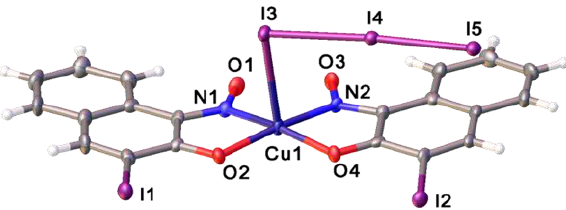
Figure 2. View of the molecular structure of 1 obtained from XRD study. Nonhydrogen atoms are given as probability ellipsoids of atomic displacements ( p = 0.5).